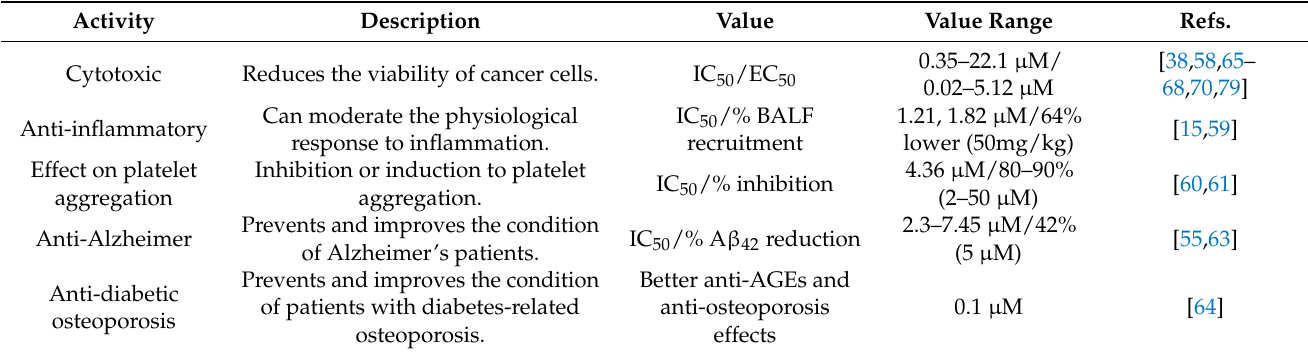
Table 7. Timosaponin AIII ( 20 ) bioactivities.